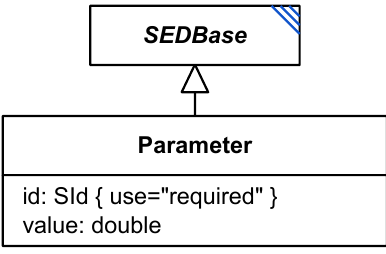
Figure 2.4: The Parameter